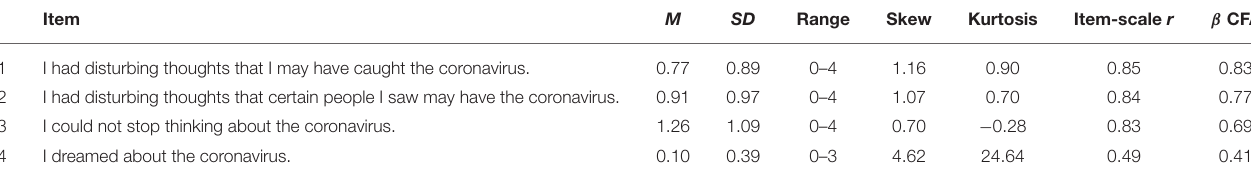
TABLE 1 | Descriptive statistics and CFA in the Iranian sample. Item